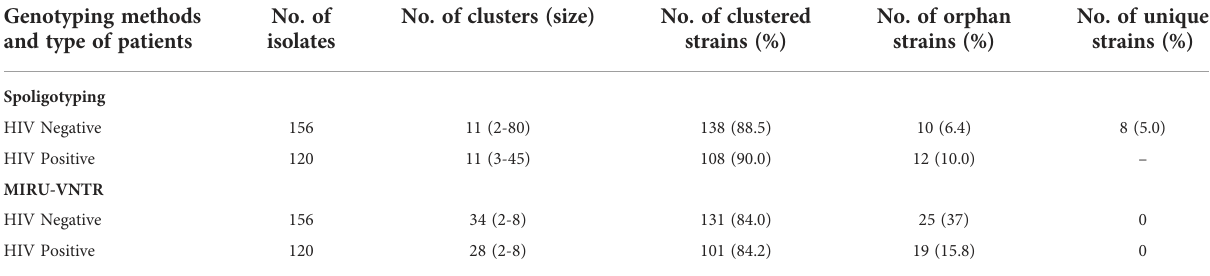
TABLE 5 Overall clustering patterns of MTB isolates by both the molecular techniques in HIV-negative and HIV-positive patients. Genotyping methods and type of patients